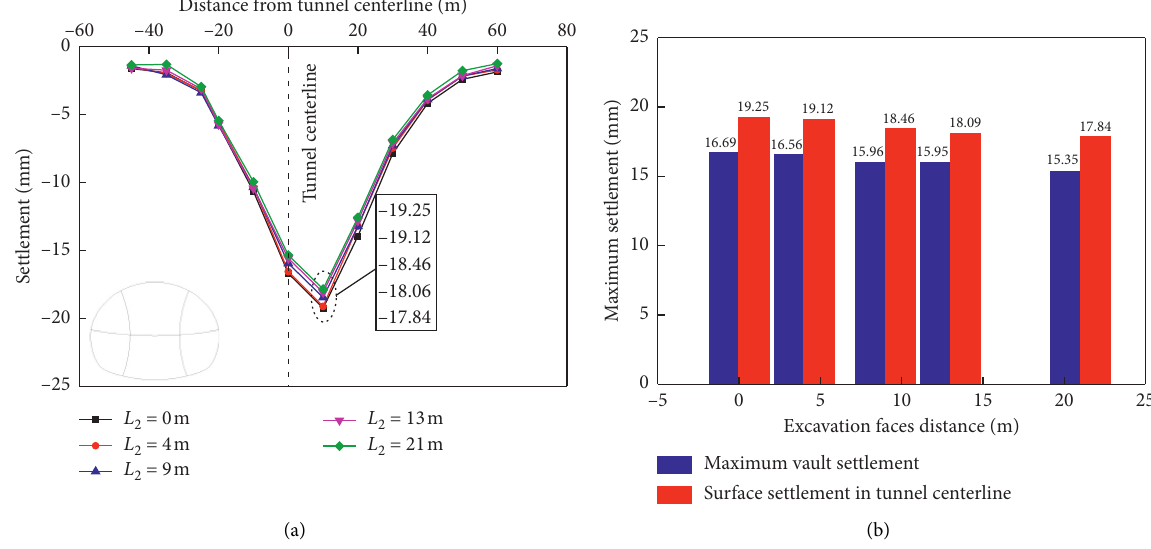
Figure 7: Surface settlement characteristics of CK9 +462 section. (a) Surface subsidence curves with different excavation face distances. (b) Relationship between maximum vault settlement, surface settlement in tunnel centerline, and excavation face distance ( L 2